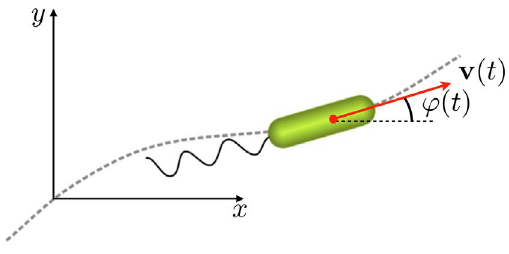
Figure 2. Setup of the model. A cell with velocity v ( t ) moves at constant speed v . The angle Q ( t ) between the velocity vector v ( t ) and the x axis defines the direction of cell motion.